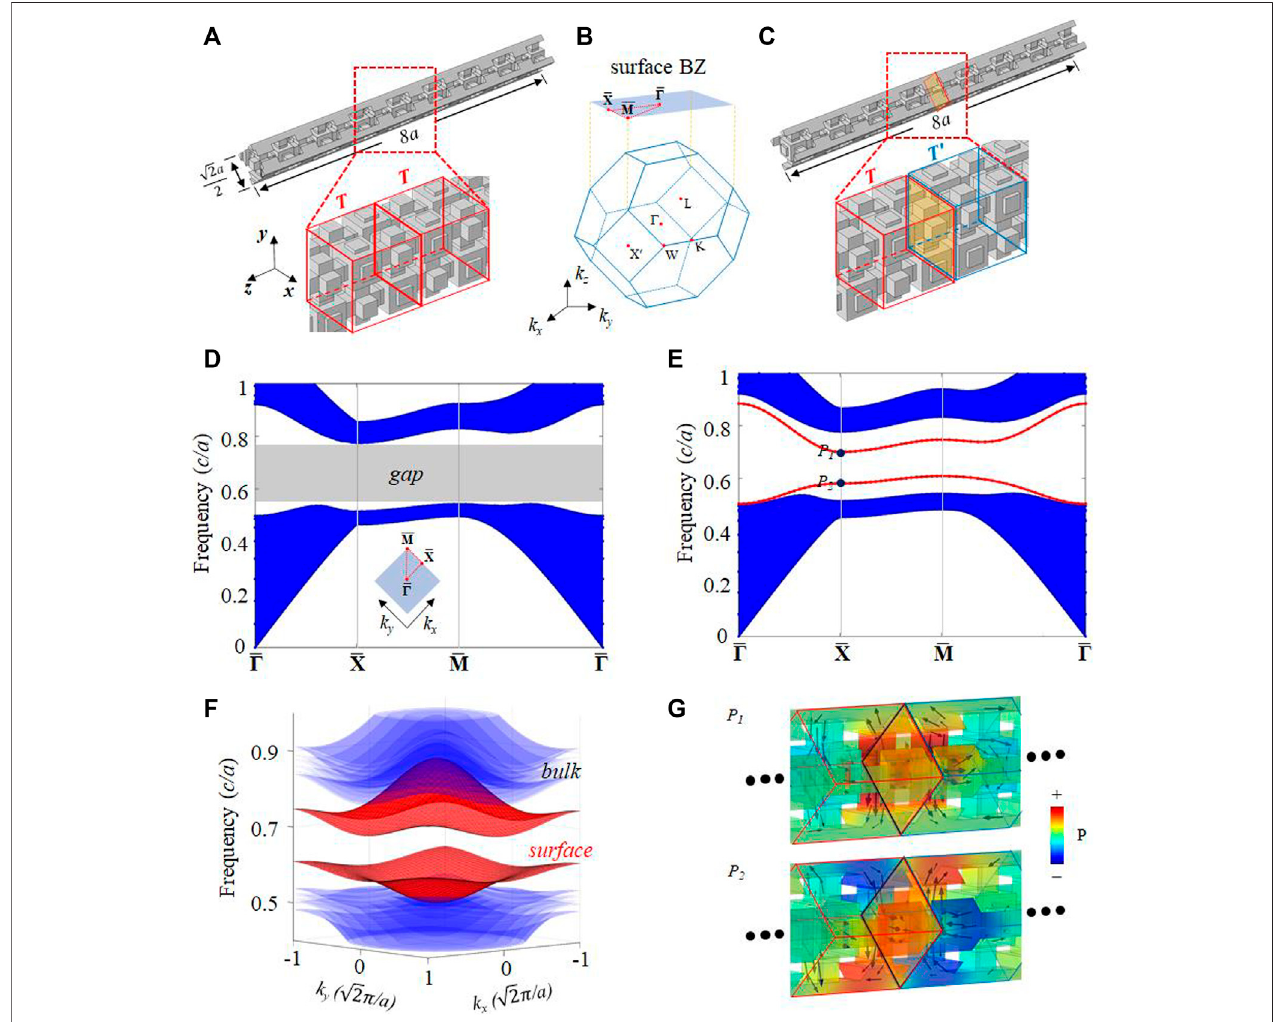
FIGURE 3 | Surfaces states on the mirror-symmetry domain wall. (A) Supercell con fi guration without domain wall. (B) The bulk BZ and (001) surface BZ. (C) Supercell con fi guration with amirror-symmetry domain wall. (D-E) Projected band structures on (001) surface corresponding to (A) and (C) , respectively. (F) 3D viewof surface states in (E) . (G) Acoustic fi eld distributions at points P 1 and P 2 in (E) , where black arrows represent the directions of energy fl ow.